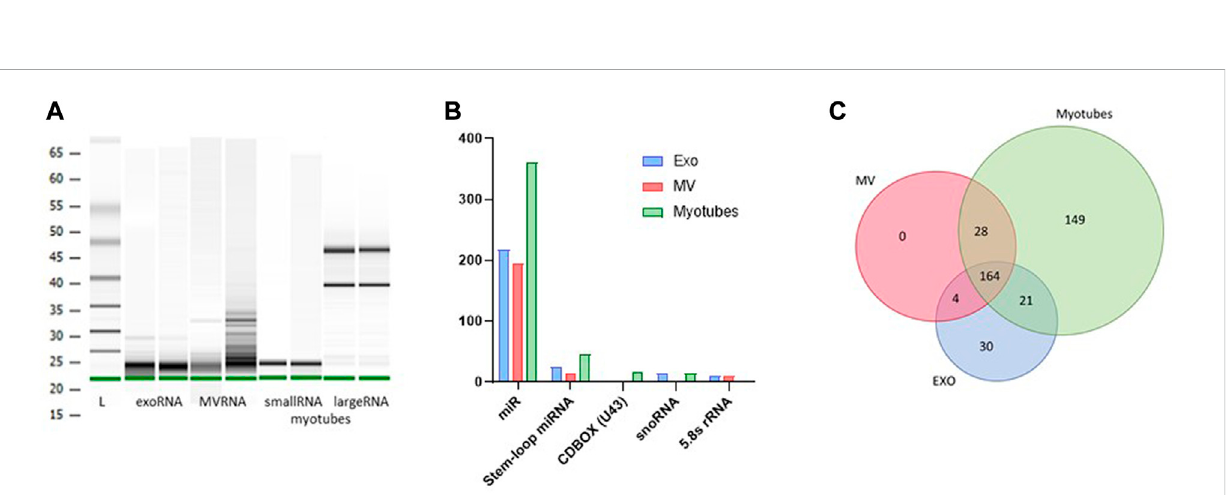
FIGURE 3 Content of non-coding RNA in exosomes (EXO), microvesicles (MV) and myotubes from unstimulated cells. Quality assessment of isolated RNA from exosomes, MV, and myotubes by Agilent BioAnalyzer with two representative samples of each (A) . Small non-coding RNA in exosomes, MV, and myotubes were identi fi ed by microarray transcriptomics. Distribution of total non-coding RNA content of EXO, MV, and myotubes (B) . The total number of microRNAs (miR) that were unique and common for EXO, MV, and myotubes (C)